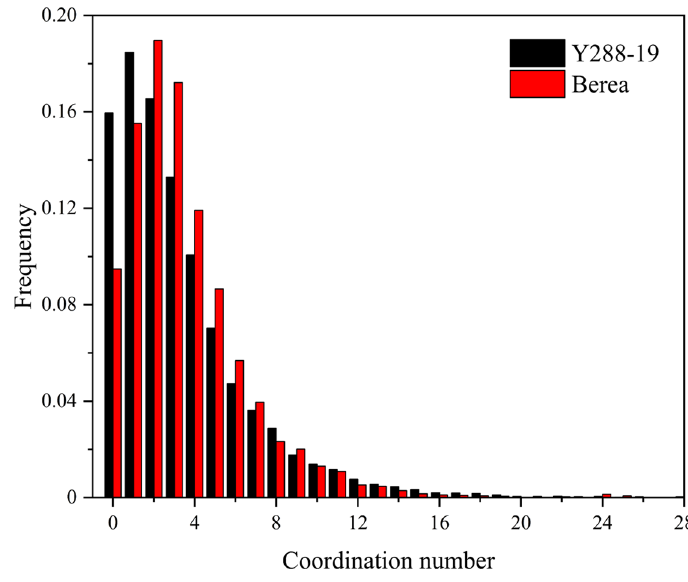
Figure 11. The coordination number of two types of cores.